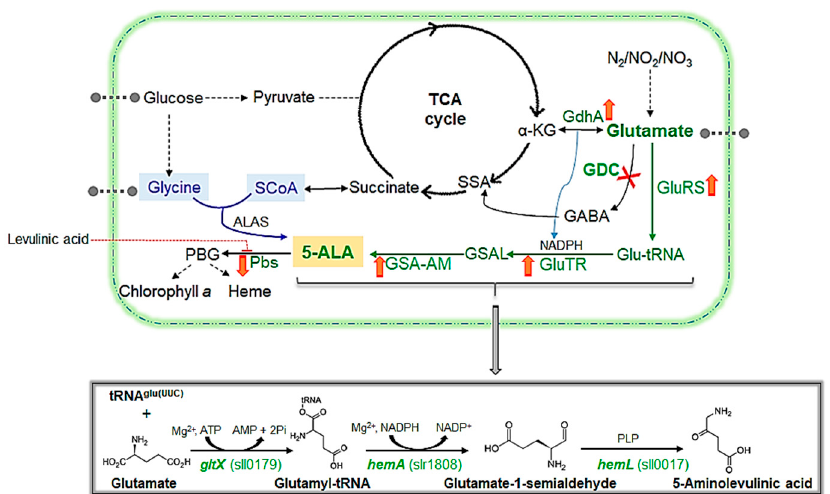
Figure 1. Schematic summary of the ALA biosynthetic pathways in prokaryotes. The C4 pathway (Shemin pathway) is marked in blue, while the C5 pathway (Beale pathway in Synechocystis ) is marked in green. The native enzymes relevant to the ALA metabolism in Synechocystis are marked in green. The pathway engineered in this study is indicated with a red ‘X’ that symbolises the effect of the gene knockout. Cascade reactions are indicated with dashed arrows. The ALA pathway in Synechocystis comprises three enzymes: GluRS, GluTR and GSA-AM that are encoded by gltX , hemA and hemL , respectively. These enzymes facilitate the irreversible catalysis of glutamate to ALA, as shown in the overall reaction in the bottom box, along with the relevant genes and their IDs (in green). ALA is converted into PBG by the action of Pbs or of ALA dehydratase ( hemB , sll1994 ), which is the main enzyme inhibited by levulinic acid (as indicated with a red dotted arrow). The red ‘up’ and ‘down’ arrows beside the gene indicate the up- or downregulation of the genes in the ∆ Gdc strain, resulting in ALA accumulation. Abbreviations used: 2Pi, diphosphate; α -KG, α -ketoglutarate; ALA, δ -aminolevulinic acid; ALAS, ALA synthase; ATP/AMP, adenosine tri(mono)phosphate, GDC, glutamate decarboxylase; GdhA, glutamate dehydrogenase; GluRS, glutamyl-tRNA synthetase; GluTR: glutamyl-tRNA reductase; Glut-tRNA, glutamyl-tRNA; GSA-AM, glutamate-1-semialdehyde 2,1-aminomutase; GSAL, glutamate-1-semialdehyde; NADPH, nicotinamide adenine dinucleotide phosphate; PBG, porphobilinogen, Pbs, porphobilinogen synthase, PLP, pyridoxal-5 (cid:48) -phosphate; SCoA, succinyl coenzyme-A; SSA, succinic semialdehyde. Reproduced from